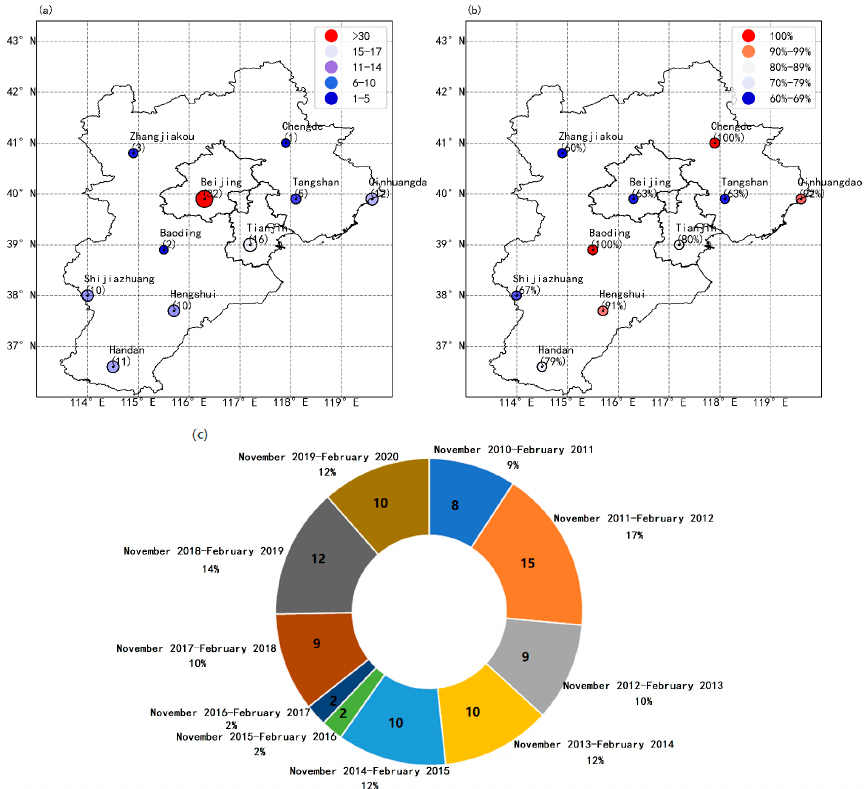
Figure 2. ( a ) Spatial distribution of the winter FRB, and ( b ) percentage of the FRB in winter against the FRB of whole year in BTH region during 2010–2020. ( c ) The doughnut chart of winter FRB in BTH region of each year. The integer on doughnut chart represents the FRB of each winter, and the percentage around doughnut chart represents the percentage of the winter FRB against the annual total FRB in each year.